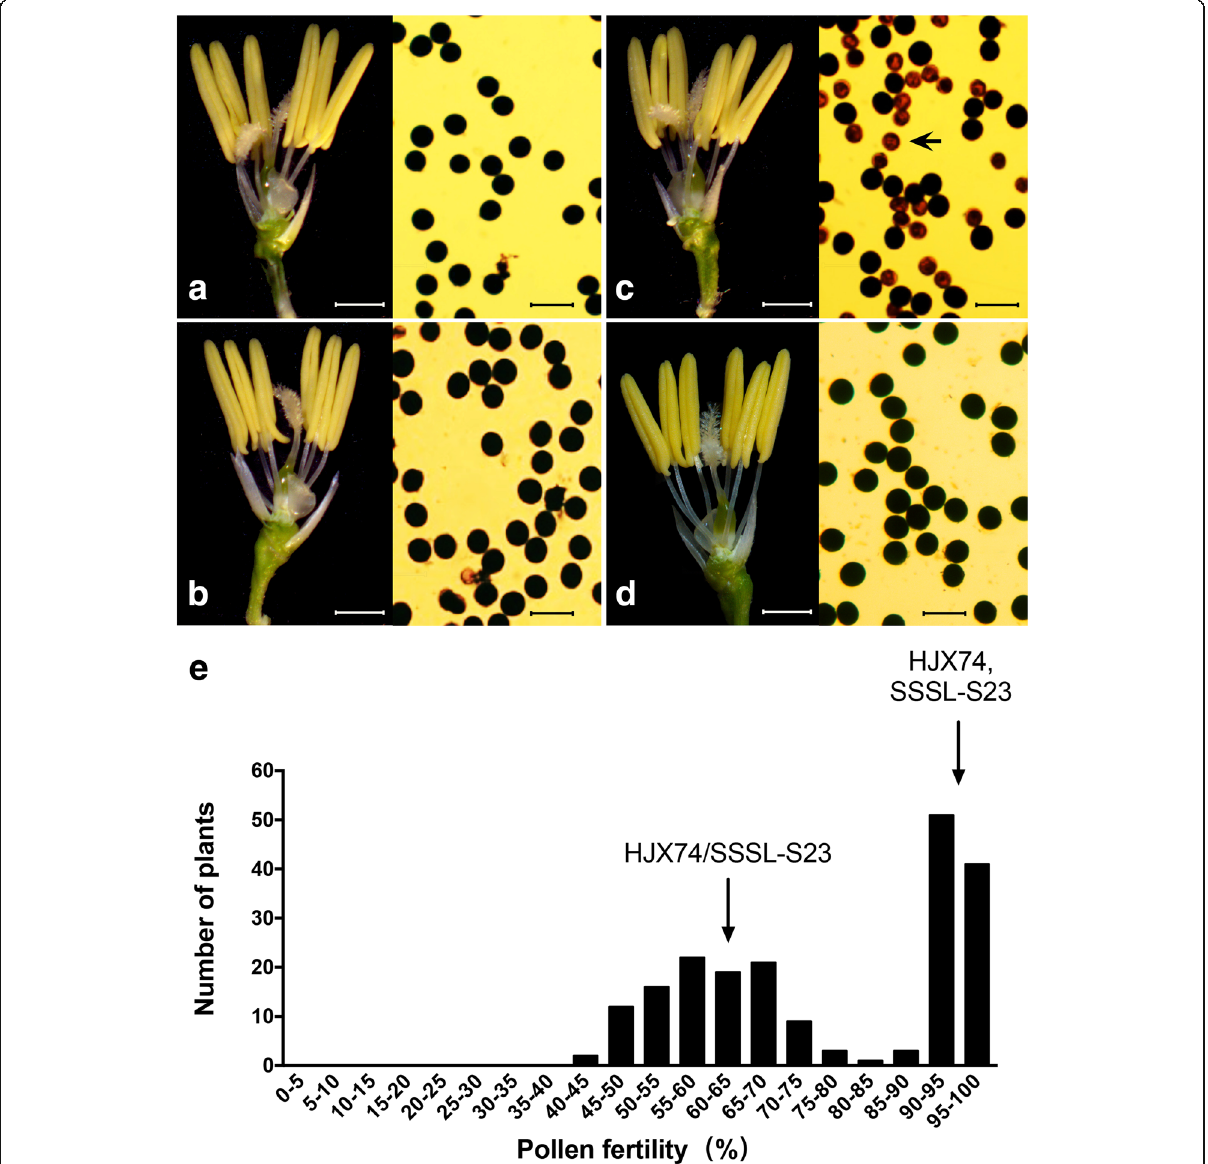
Fig. 2 Pollen fertility of HJX74, SSSL-S23, HJX74/SSSL-S23 F 1 and F 2 populations. Spikelets (left) and pollen grains (right) in HJX74 ( a in NSD), SSSL- S23 ( b in NSD) and HJX74/SSSL-S23 F 1 ( c in NSD and d in NLD) plants. Arrow indicated the aborted pollen grain. Scale bars, 1 mm for spikelet and 100 μ m for pollen. e A bimodal distribution for pollen fertility detected in 200 F 2 plants derived from the cross between HJX74 and SSSL-S23 in NSD. Arrows indicated the mean pollen fertility of HJX74, SSSL-S23 and HJX74/SSSL-S23 F 1 plants, chromosome 7 from wild rice might have a dominant QTL conferring small grain phenotype. (Fig. 4b). The self-pollinated progenies (F lines) of those 4 (Fig. 4c). Based on the sequence of a japonica standard, Nipponbare, the recombinants R-2 and R-3 restricted S23 to 11.54 kb genomic region between the SNP-2 and